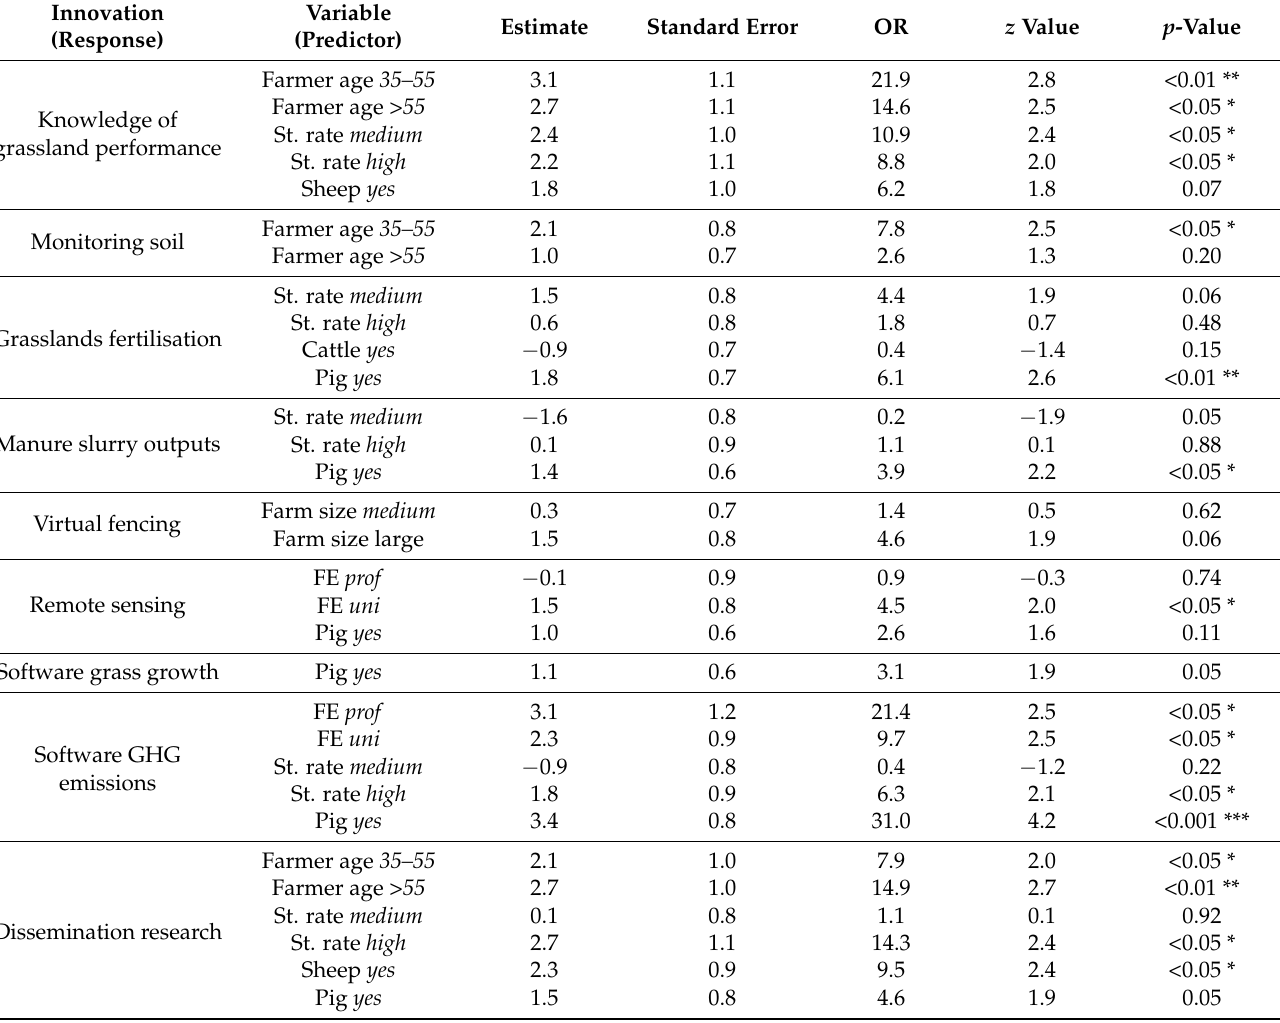
Table 3. Results of the best-fit cumulative link models of the influence of farmer and farm char- acteristics on the relevance given to the innovations. For the description of variables see Table 1 (response) and Table 2 (predictor). Categories within predictor variables are presented in italics. Missing categories within predictor variables are the reference category for the model. Estimates must be interpreted as the effect of the shift from the reference category on the score of the